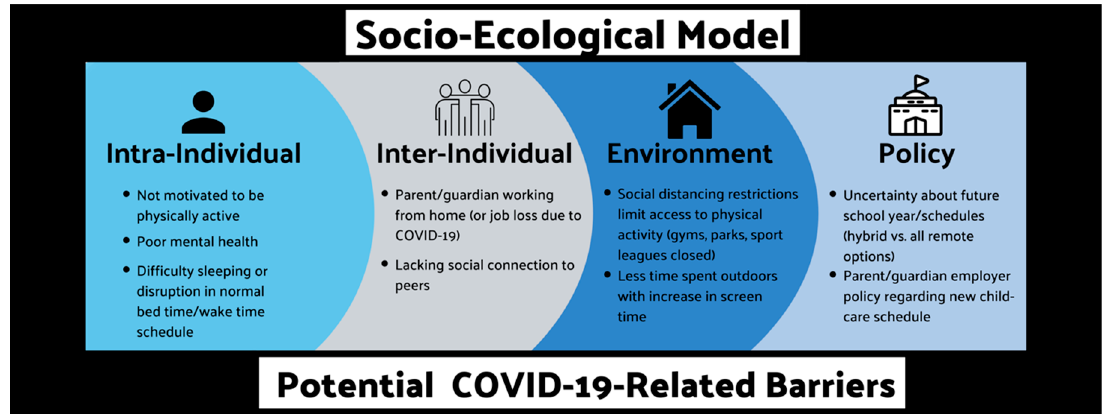
Figure 1. Examples of potential barriers to healthy behaviors across the 24-h day: socio-ecological Figure1. Examplesofpotentialbarrierstohealthybehaviorsacrossthe24-hday: model.